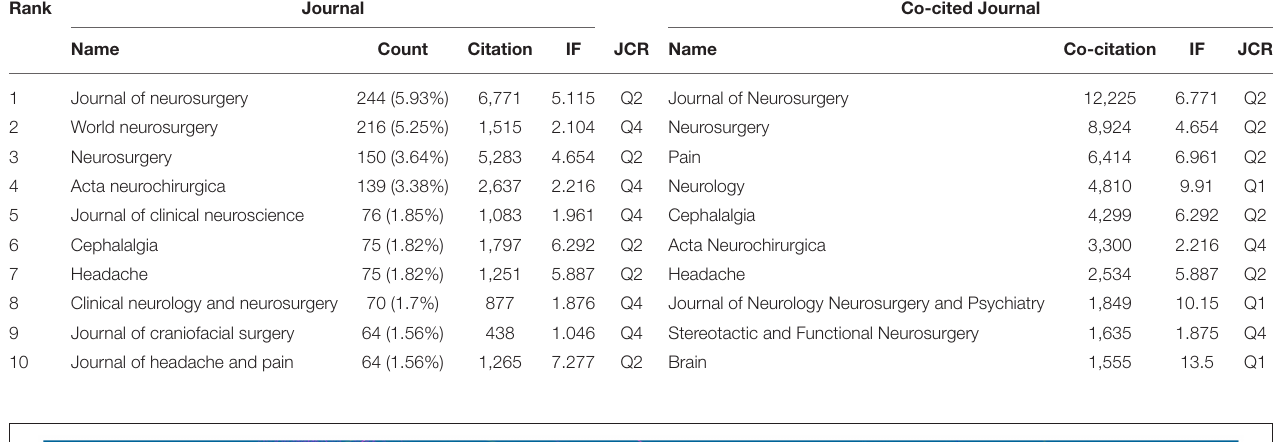
TABLE 3 | Top 10 journals and co-cited journals related to TN.